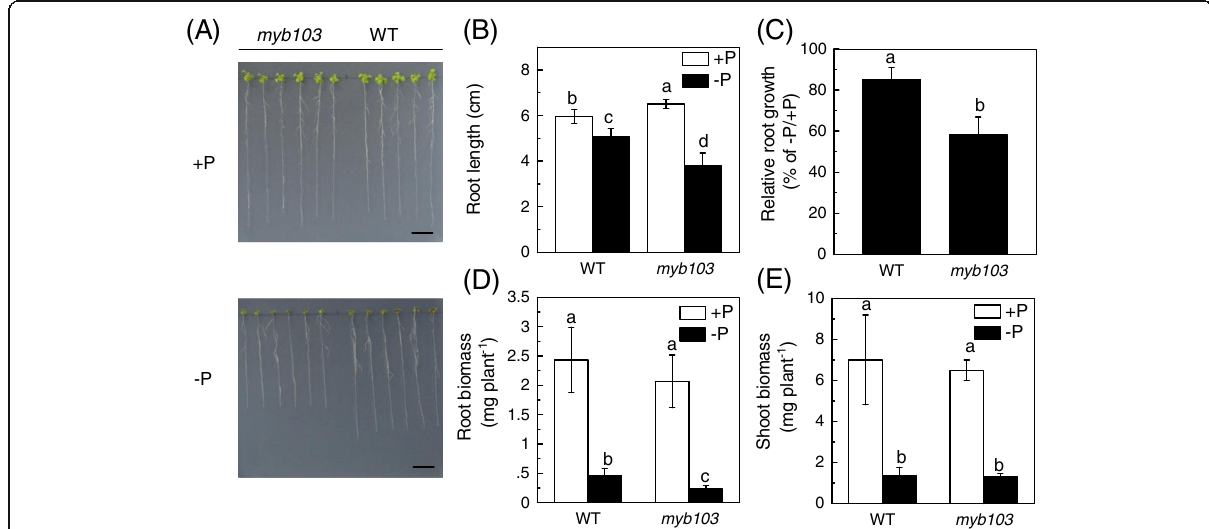
Fig. 2 Phenotype of myb103 mutant. Seeds of WT and myb103 were surface-sterilized and germinated on the complete nutrient medium, and seedlings with the root length of about 1 cm were transferred to the complete nutrient medium (+P) or medium without P ( − P) for 7 d ( a ), and root length ( b ), relative root growth ( c ), ratio of root length in +P to root length in -P), root biomass ( d ) and shoot biomass ( e ) were measured. Scale bar = 1 cm. Values are means ± SD, n = 4. Different letters on the bars indicate significant differences at p < 0.05